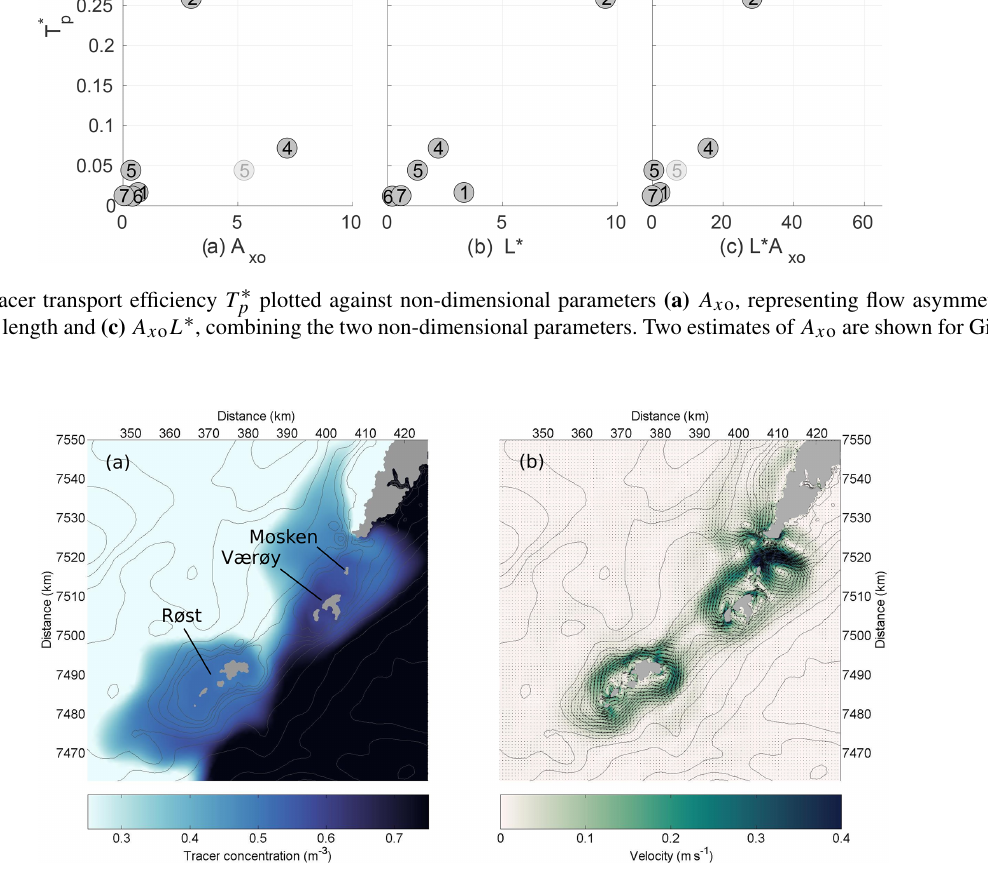
Figure 13. Time-mean tracer concentration (a) and time-mean currents (b) around the southern tip of Lofoten near the end of the simulation. Thin contours show the bottom